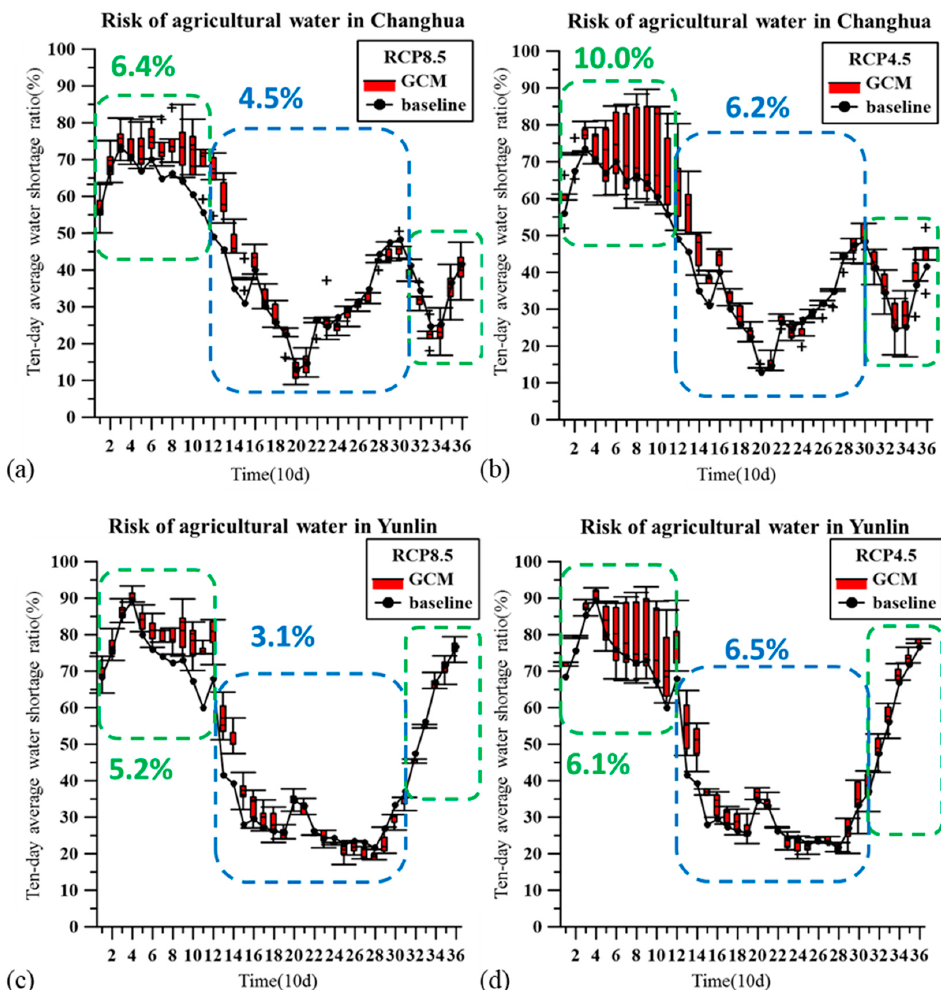
Figure 8. Water shortage ratio (R) of the irrigation water in Changhua under RCP 8.5 ( a ) and RCP4.5 ( b ) and in Yunlin under RCP 8.5 ( c ) and RCP4.5 ( d ).